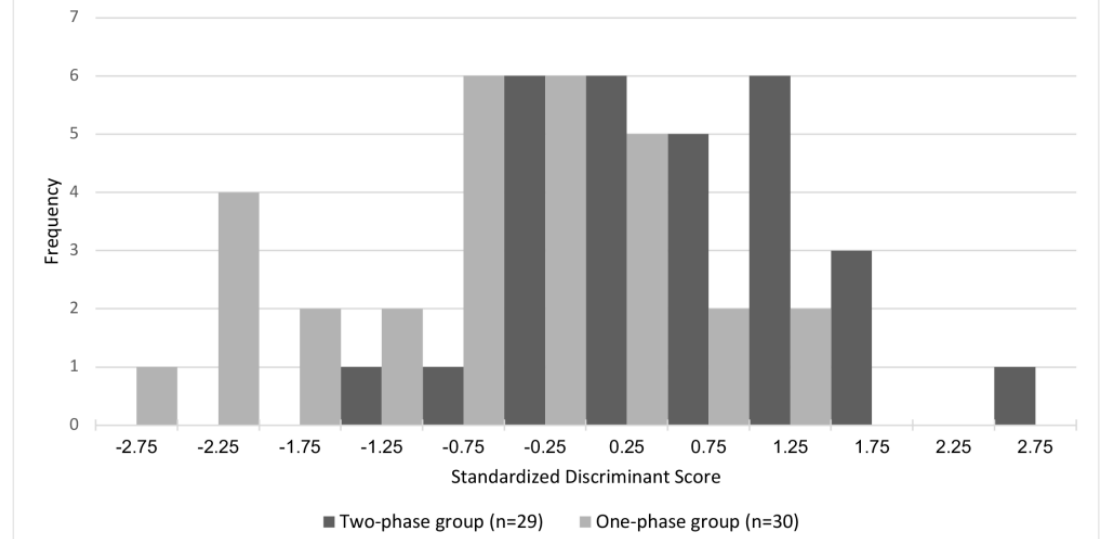
Figure 3. Standardised discriminant scores of the two-phase and one-phase group. Patients in the two-phase treatment group tended to have more positive discriminant scores, whereas patients in the one-phase treatment group tended to have more negative discriminant scores.